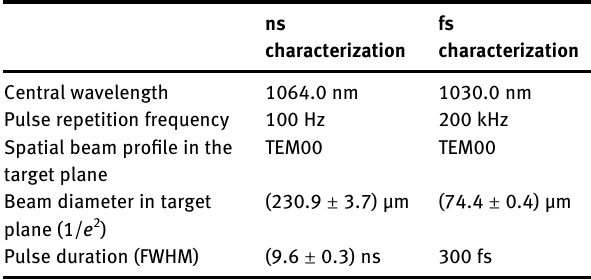
Table  : Characteristics of the lasers employed in LIDT